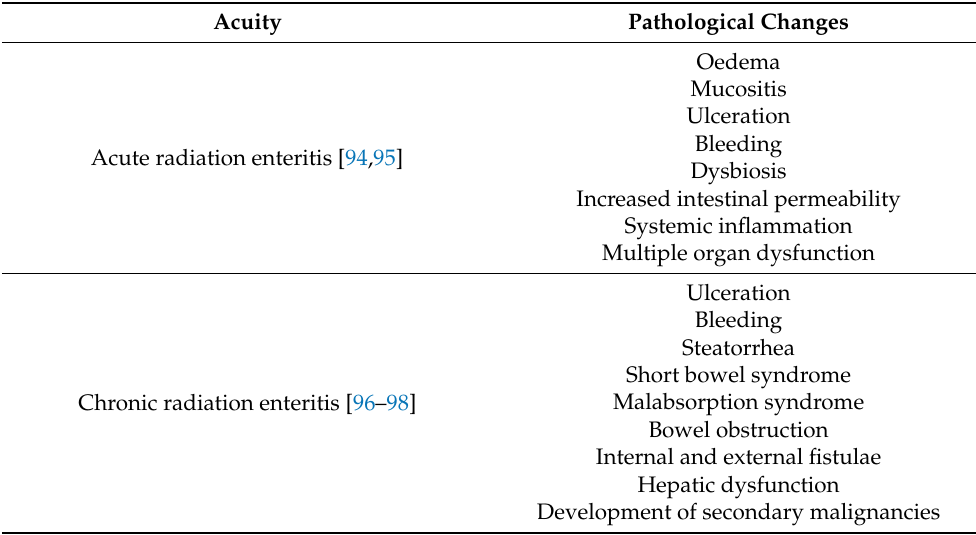
Table 2. List of acute and chronic effects of ionizing radiation of the small intestine. Acuity Pathological Changes